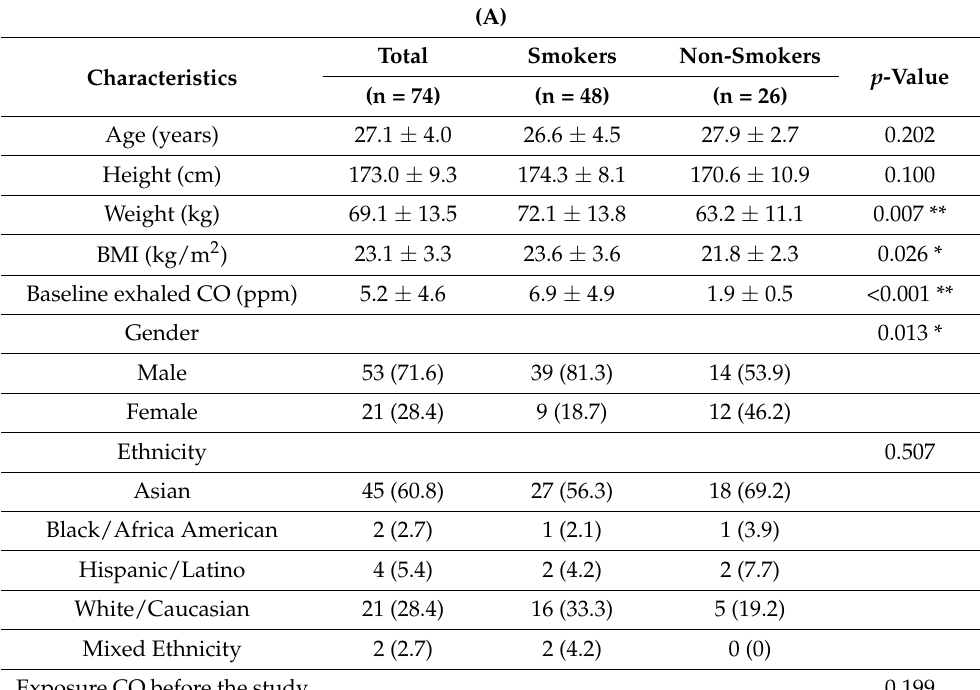
Table 1. ( A ) . Demographics, physiological and baseline exhaled CO of the study participants by smoking status. ( B ) . Demographics, physiological, smoking-related and baseline exhaled CO characteristics of light smokers and heavy